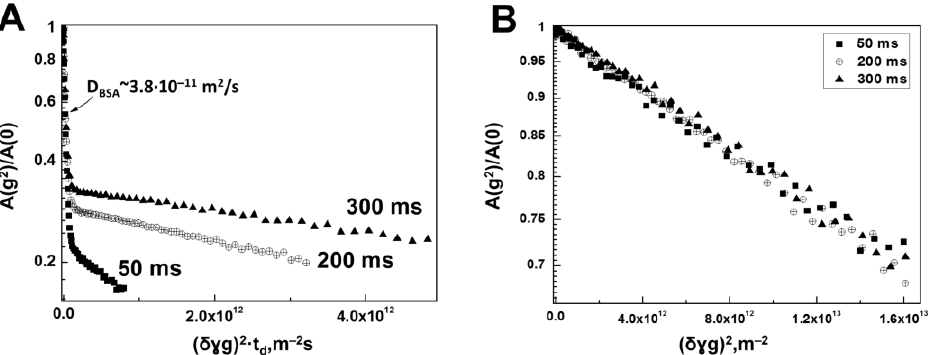
Figure 4. ( A ) Diffusion decays of a water solution of a mixture of HA and BSA at polysaccharide and protein concentrations of 0.75% and 4% (wt.) respectively, obtained by integrating signals located in the range of chemical shifts from 1.8 to 3.8 ppm at various diffusion times of 50, 200 and 300 ms. ( B ) The diffusion decays for HA molecules only, obtained by subtracting the contribution to the signal of the spin echo of BSA molecules and plotted in coordinates as a function of 𝛾 2 𝑔 2 𝛿 2 , demonstrating a restricted diffusion regime.